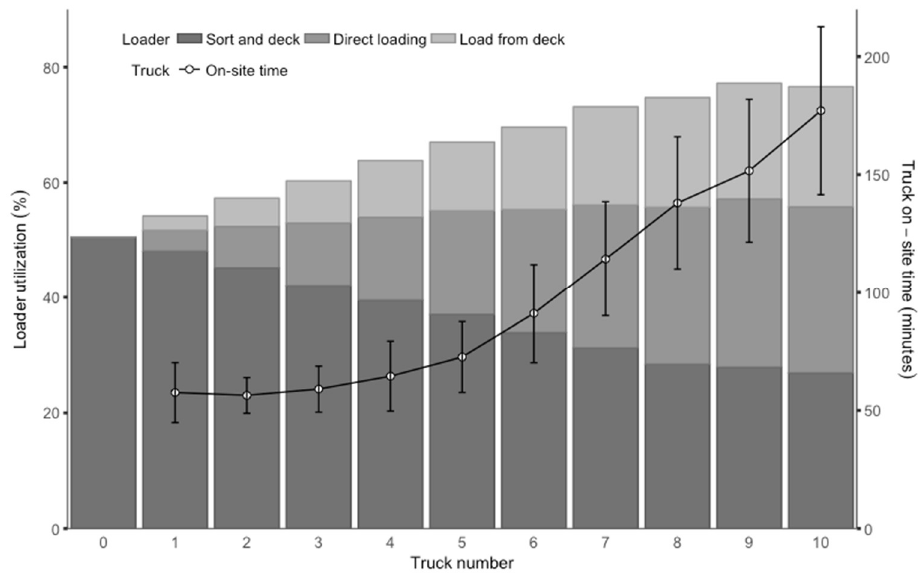
Figure 9. Loader utilization with task proportions (left y-axis) and truck on-site time (right y-axis) under different trucking schedules.